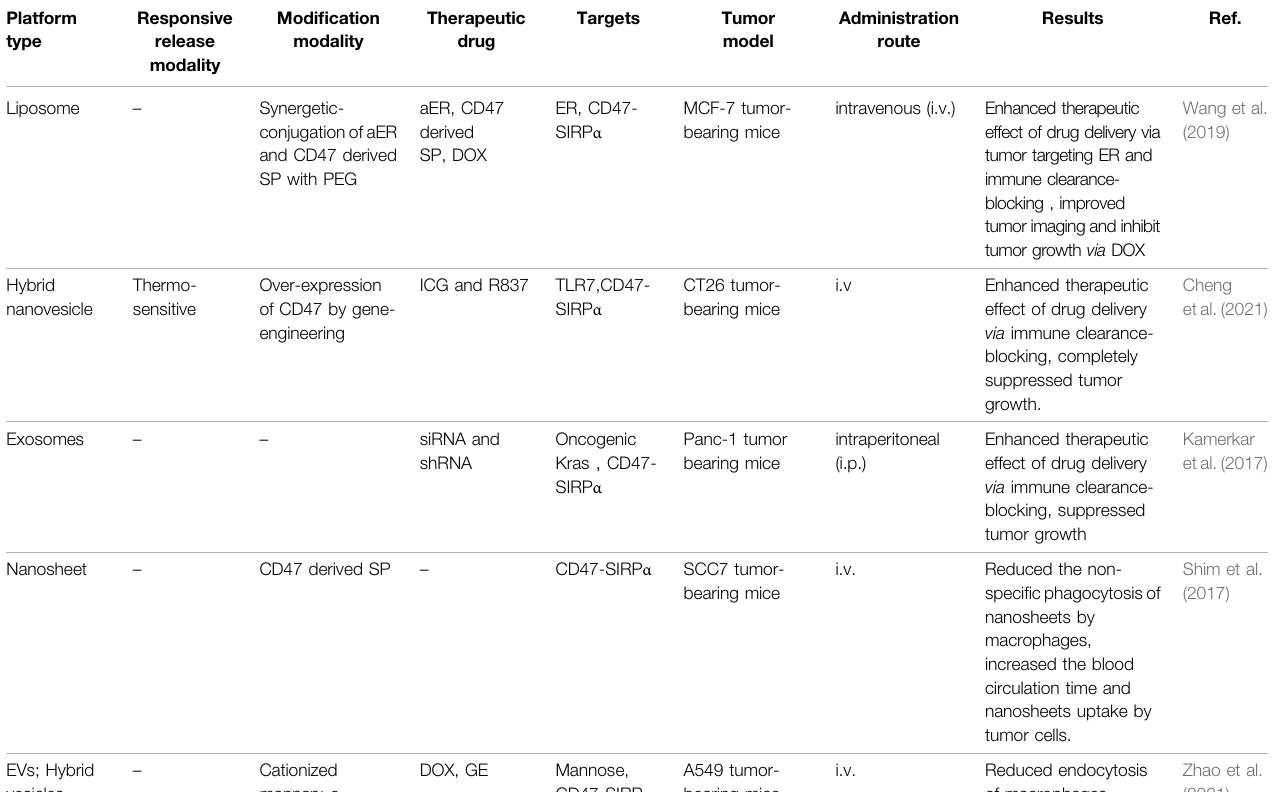
TABLE 4 | Examples of nanoparticle-based combination therapy utilized activating CD47-SIRP α signal axis. Platform